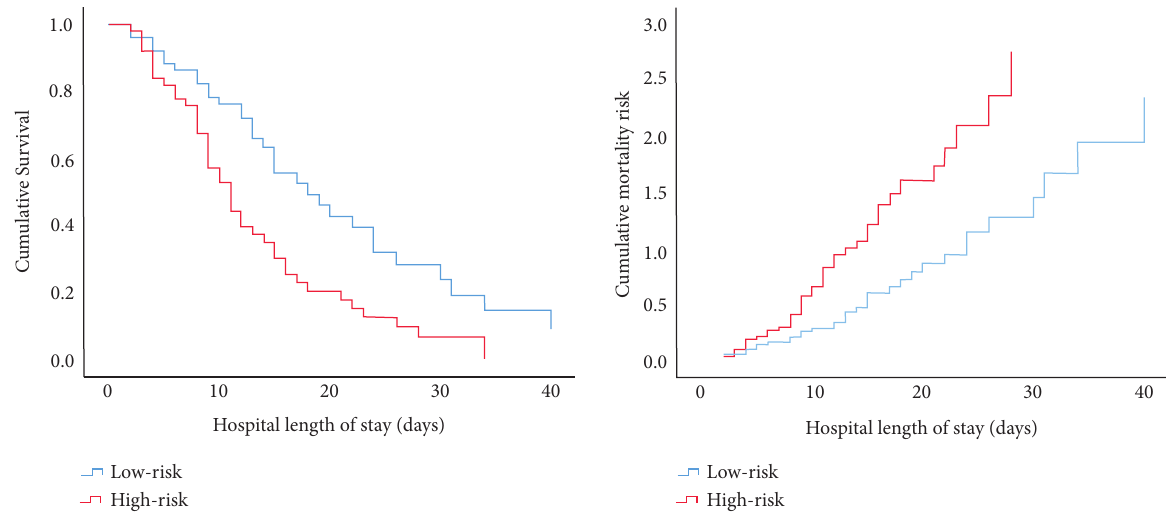
Figure 2: Cumulative survival and mortality risk multivariate Cox regression